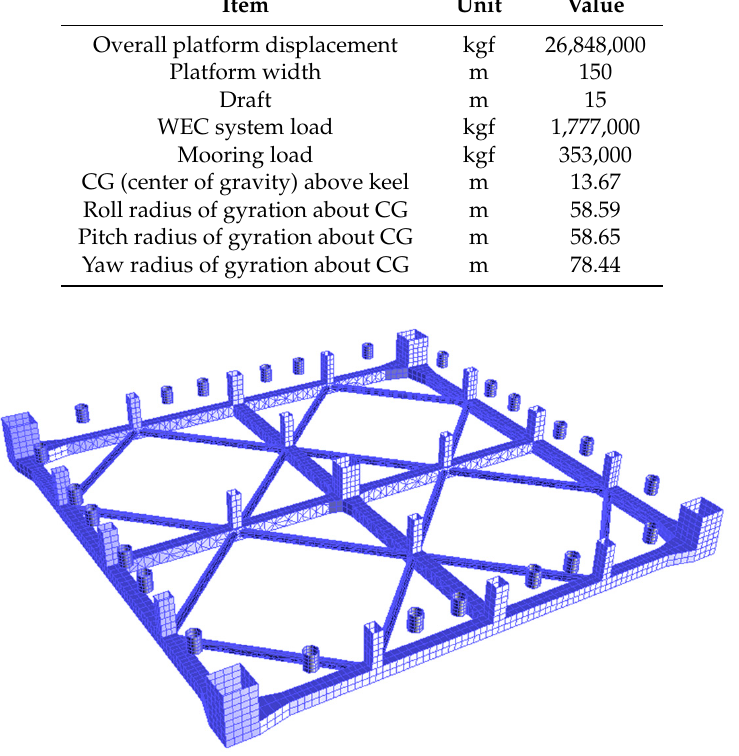
Figure 1. Wind-wave hybrid platform concept.